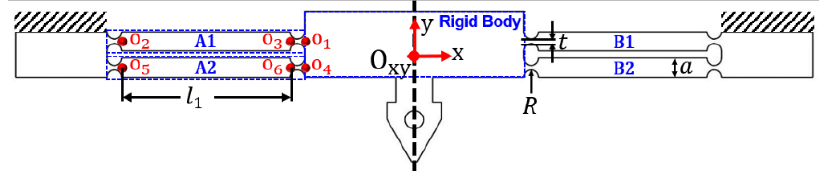
Figure 2. Cross-section view of the double parallelogram flexure mechanism, where 𝑅 is radius of circular notch, 𝑡 is thickness between two circular notches, 𝑎 is the width and height of the linkage, and 𝑙 1 is the length of LSFH